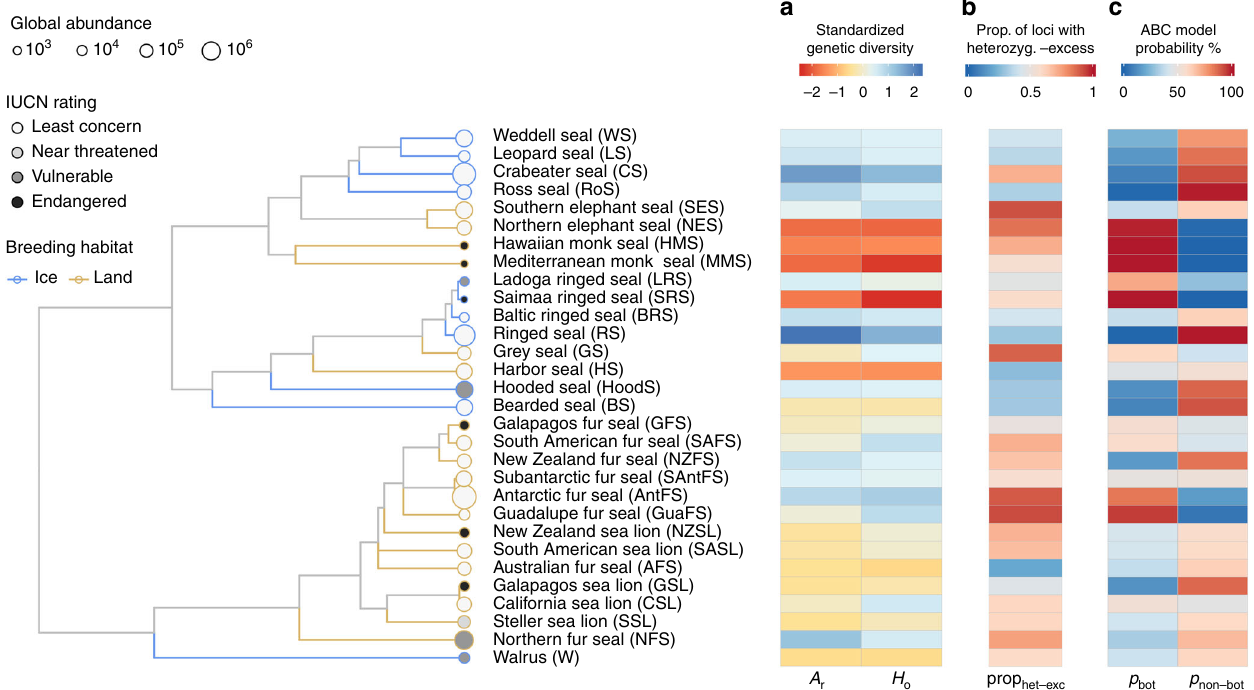
Fig. 1 Patterns of genetic diversity and bottleneck signatures across the pinnipeds. The phylogeny shows 30 species with branches colour coded according to breeding habitat and tip points coloured and sized according to their IUCN status and global abundance respectively. a Shows two genetic diversity measures, allelic richness ( A r ) and observed heterozygosity ( H o ), which have been standardised by randomly sub-sampling ten individuals from each dataset 1000 times with replacement and calculating the corresponding mean. b Shows the proportion of loci in heterozygosity-excess (prop het-exc ) calculated for the TPM80 model (see Methods for details). c Summarises the ABC model selection results, with posterior probabilities corresponding to the bottleneck versus non-bottleneck model. The raw data are provided in Supplementary Tables 2 and